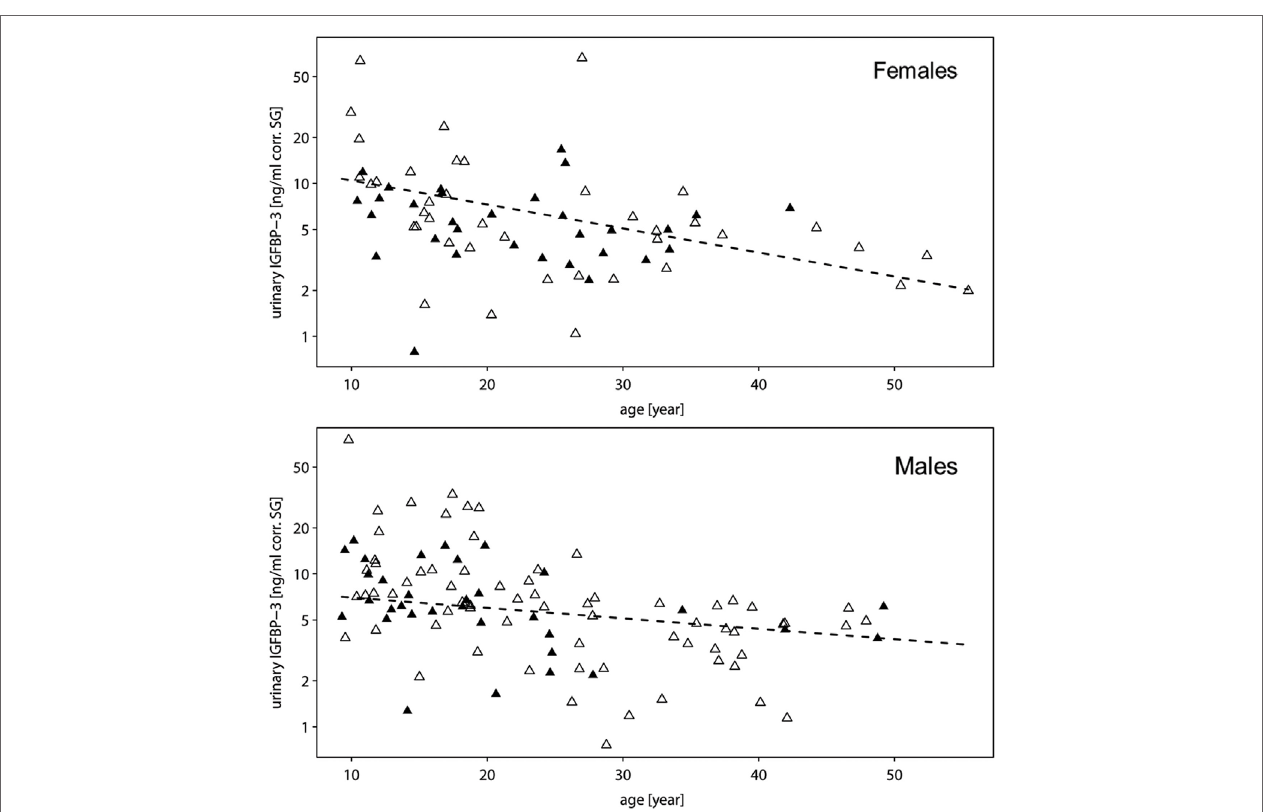
FigUre 2 | Measures of urinary igFBP-3 levels corrected for specific gravity (corr. sg) from female (upper plot) and male (lower plot) bonobos (open triangles) and chimpanzees (filled triangles) in relation to chronologic age . The y -axis is displayed on a log scale. Sample sizes: N bonobos = 71 (31 males, 40 females), N chimpanzees = 102 (33 males, 69 females).